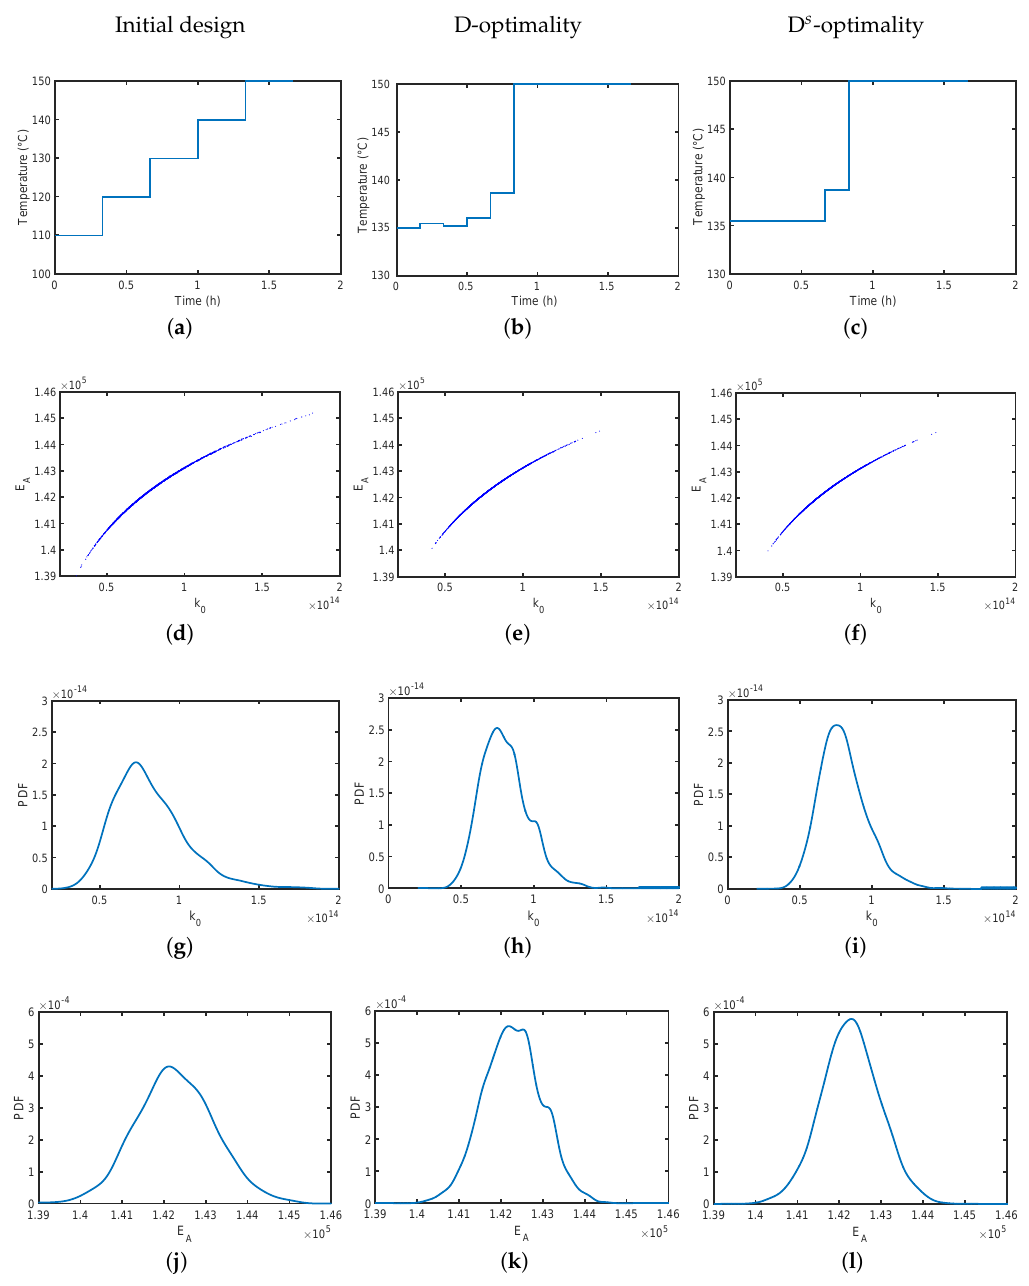
Figure 5. Performance of the initial setting and MB-OED. D s -optimality means a simplified temperature profile in comparison to D-optimality. ( a ) is the initial; ( b ) the optimally designed; and ( c ) the optimal but simplified temperature profile; ( d – f ) are the scatter plots for the estimated parameters assuming simulated noisy data for 2000 MC simulations; ( g – l ) are the corresponding parameter probability